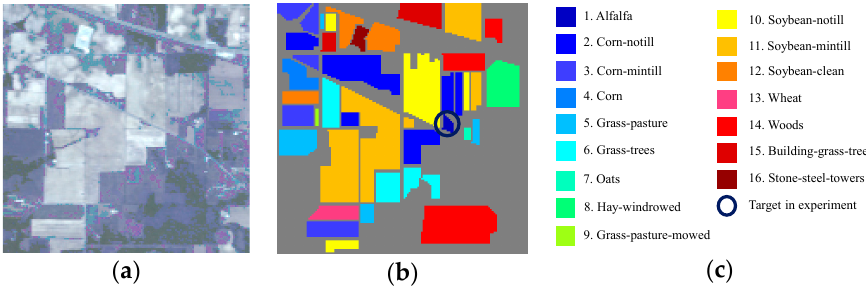
Figure 11. ( a ) The false color sense of Indian Pines data (bands 33, 23, 17). ( b ) The ground truth of the different categories. ( c ) The legend of different categories.